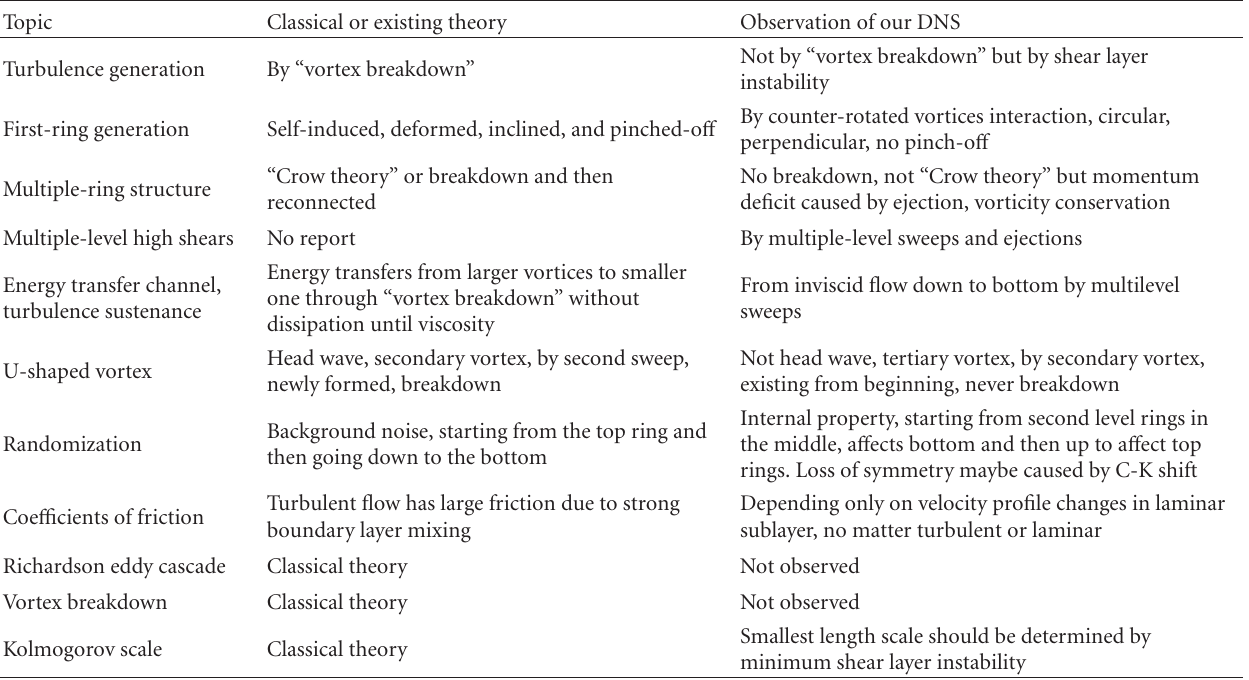
Table 2: Comparison of classical theory and our DNS